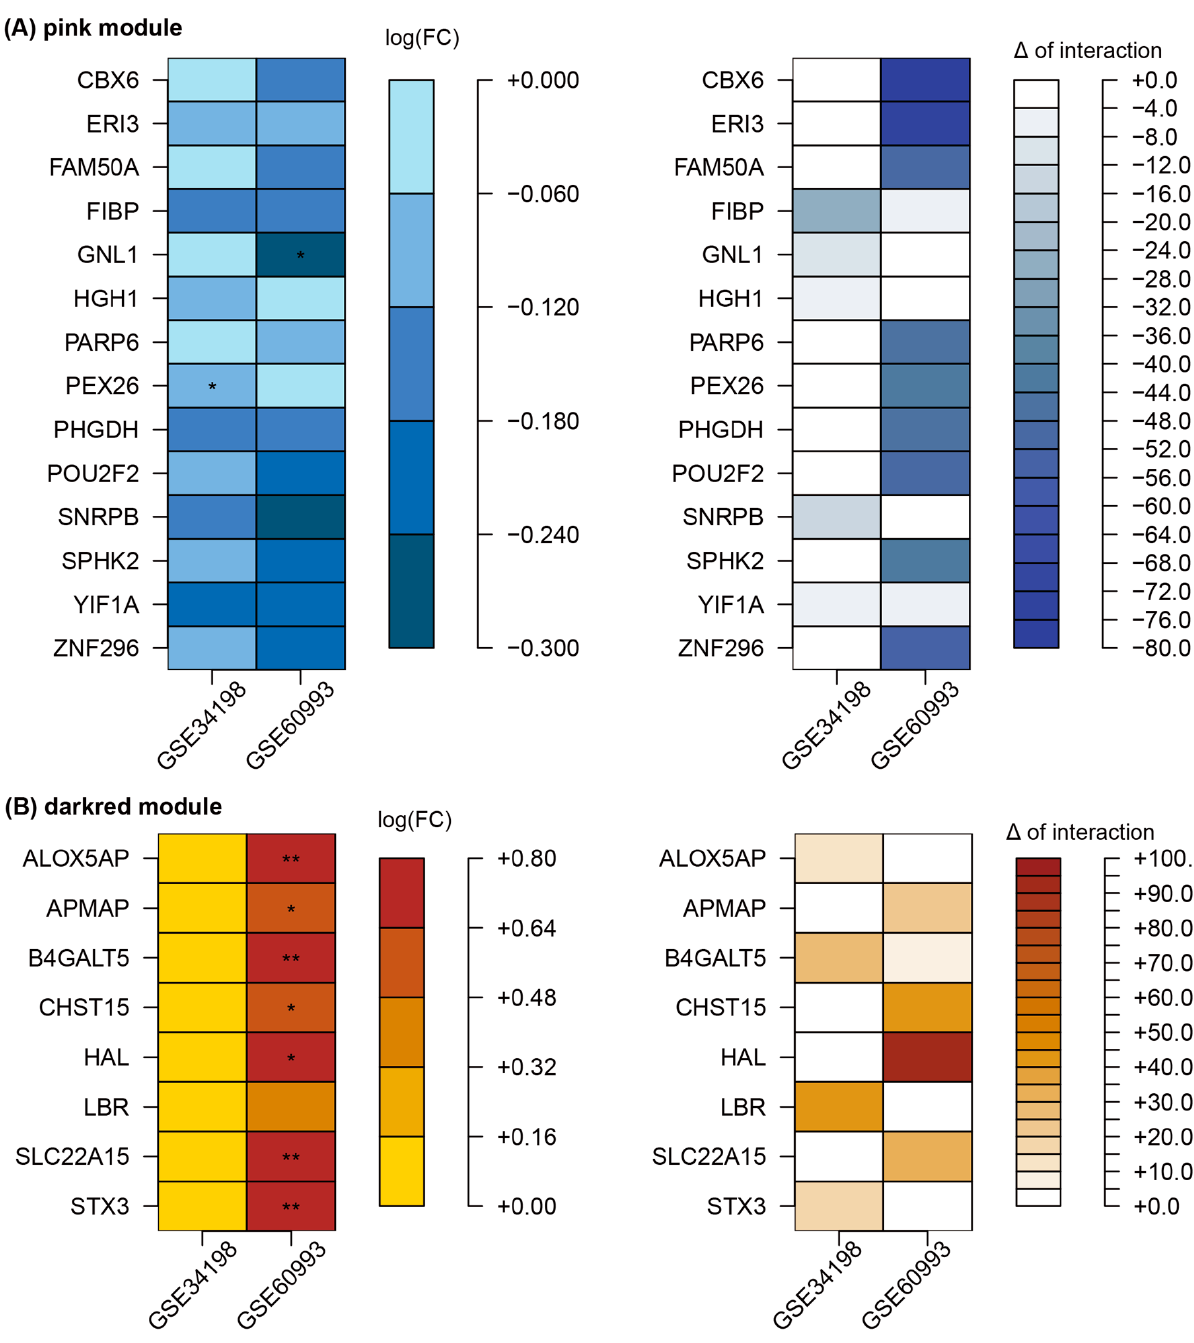
Figure 7. Representative ACS-related genes in the pink ( A ) and dark-red ( B ) modules. FC values (logFC) between two conditions were calculated using the limma package. Delta ( Δ ) of interaction indicates the difference between the number of interactions in ACS and matched control groups. **, and * denote p < 0.01, and p < 0.05, respectively. Abbreviations: CAD, coronary artery disease; FC, fold change.